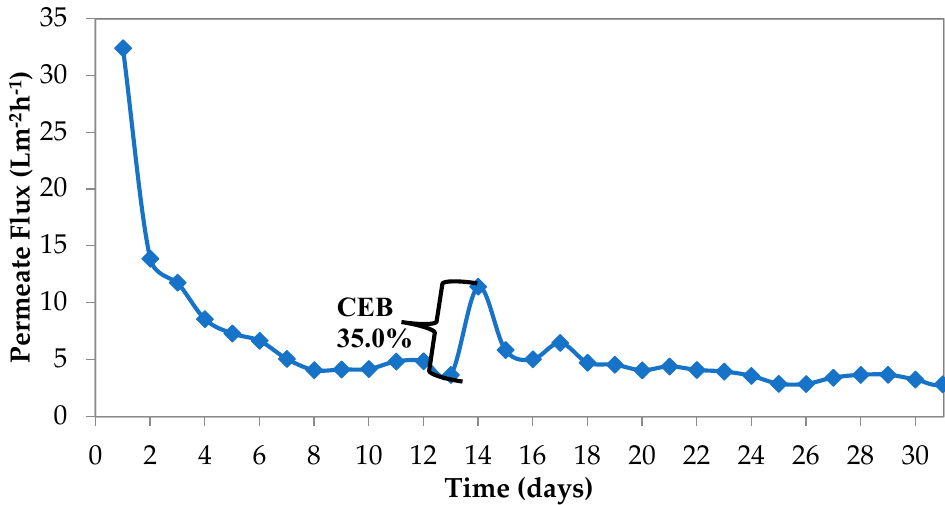
Figure 5. Temperature corrected flux versus time plot of a diffuser with 5 mm of hole diameter (40 mg/L AS-1 and 15–18 g/L of MLSS).